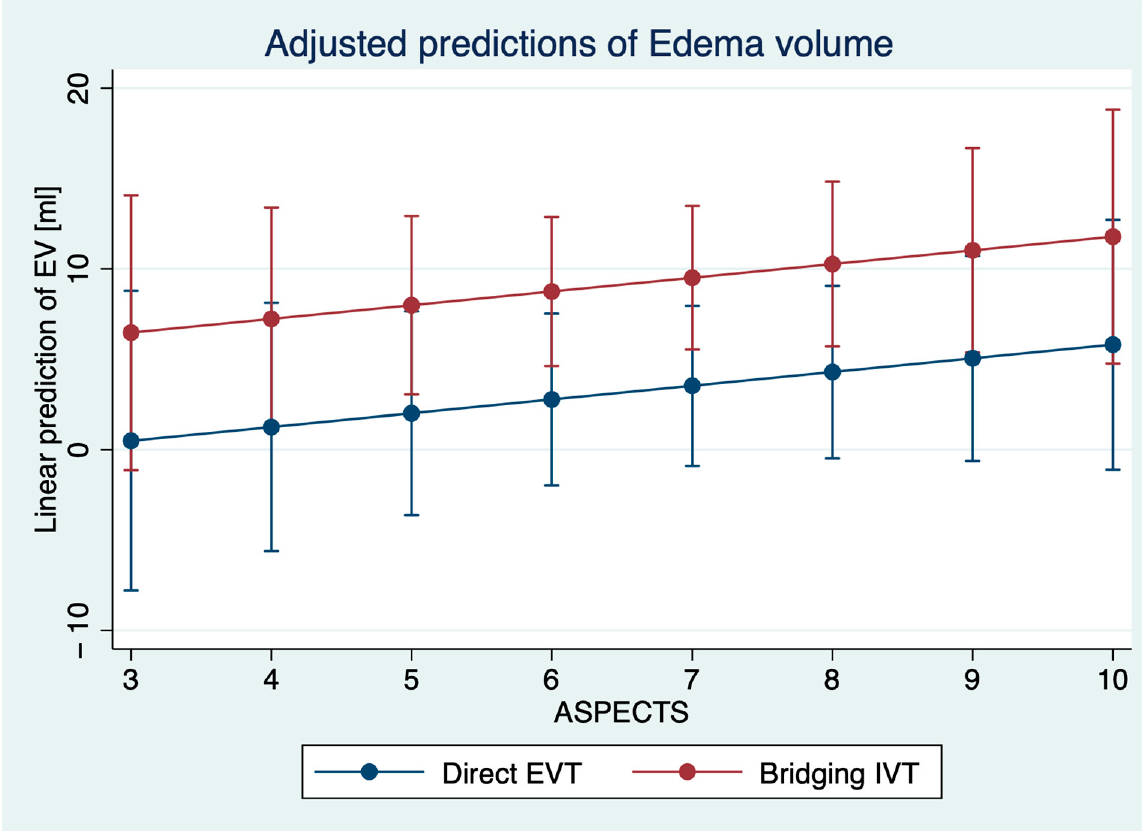
Figure 3. Prediction of edema volume ( y axis) based on multivariable linear regression analysis to show the impact of IVT application according to the baseline ASPECTS. No further variable was independently associated with EV.